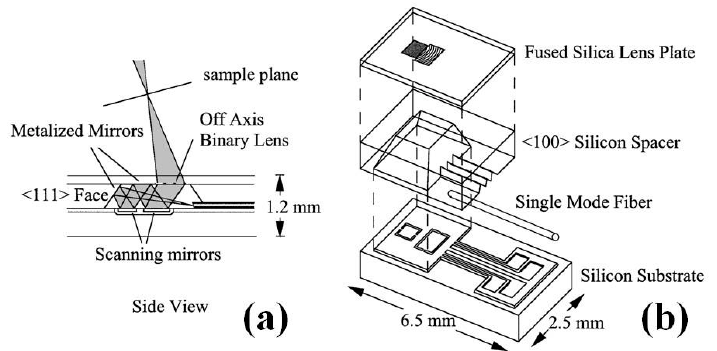
Figure 9. Micromachined scanning confocal optical microscope ( µ COSM): ( a ) side-view of the microscope showing the zigzag beam path; and ( b ) exploded isometric view showing the lens plate, spacer element, and scan mirror element that constitute the µ COSM, which consists of a single-mode optical fiber for illumination and detection, two torsional mirrors for scanning, and a binary transmission grating as the objective lens (Reproduced with permission from OSA [70]).